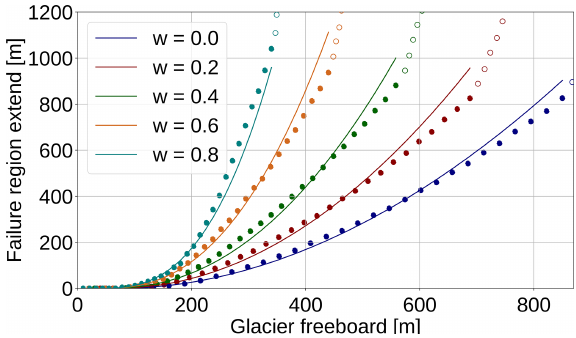
Figure 5. Size of shear failure region L as a function of glacier freeboard F = H − D and relative water depth w = D/H . Numer- ical results are shown for smaller freeboards where the failure re- gion does not encompass the whole ice thickness (filled dots) and for large freeboards, where the failure region contains the whole ice thickness (empty circles). A power law has been fitted to the numer- ical results for small freeboards (continuous line), which is given by Eq. (15). The fit has been optimized for relative error in order to get the onset of cliff calving